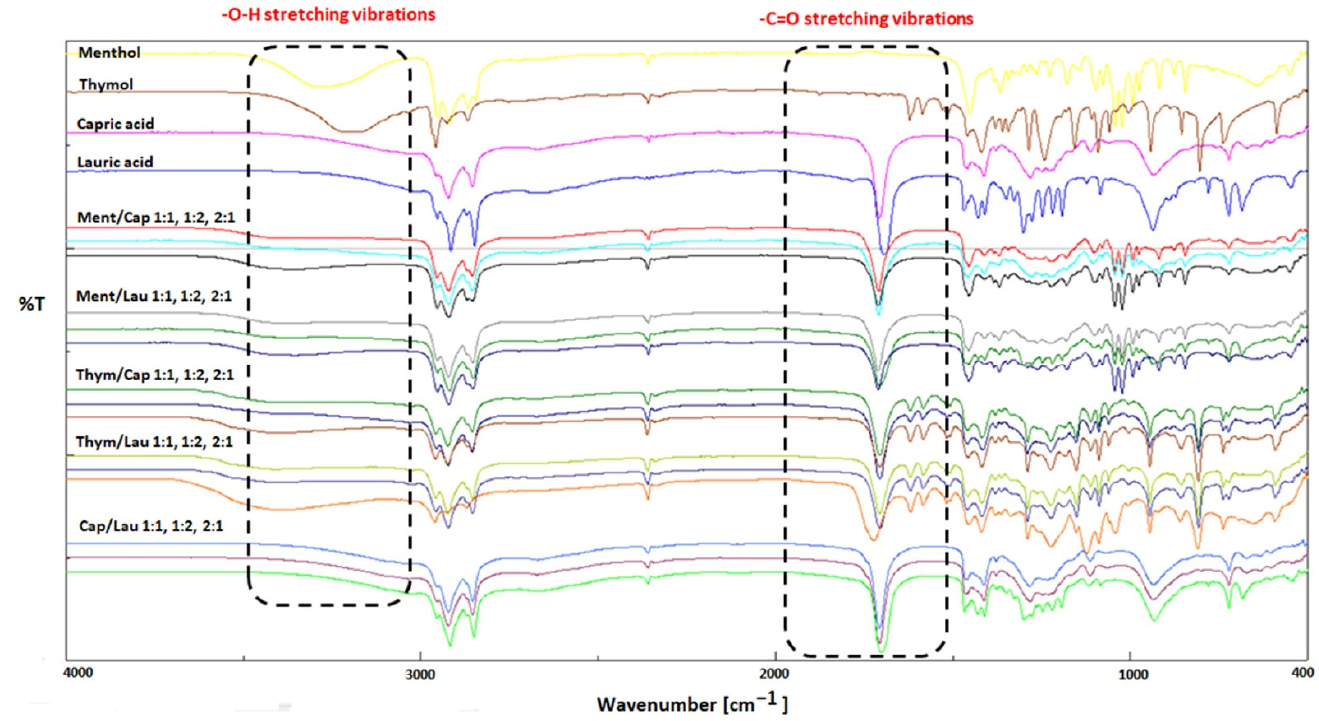
Figure 1. FT-IR spectra of pure menthol, thymol, capric acid and lauric acid as well as of the prepared HNADESs.